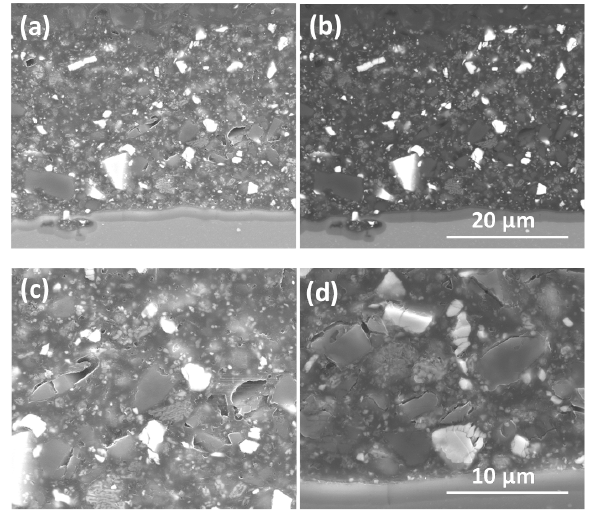
Figure 9. ( a ) Secondary and ( b ) backscattered electron images of voids resulting from the dissolution of Li 2 CO 3 inhibitor particles after 500 h NSS exposure; ( c ) Magnification of ( b ); ( d ) Interfacial voids between the primer and the Li 2 CO 3 inhibitor particles deep in the primer near the primer/anodised layer interface. Dashed box in ( a ) indicates the region in ( c ).